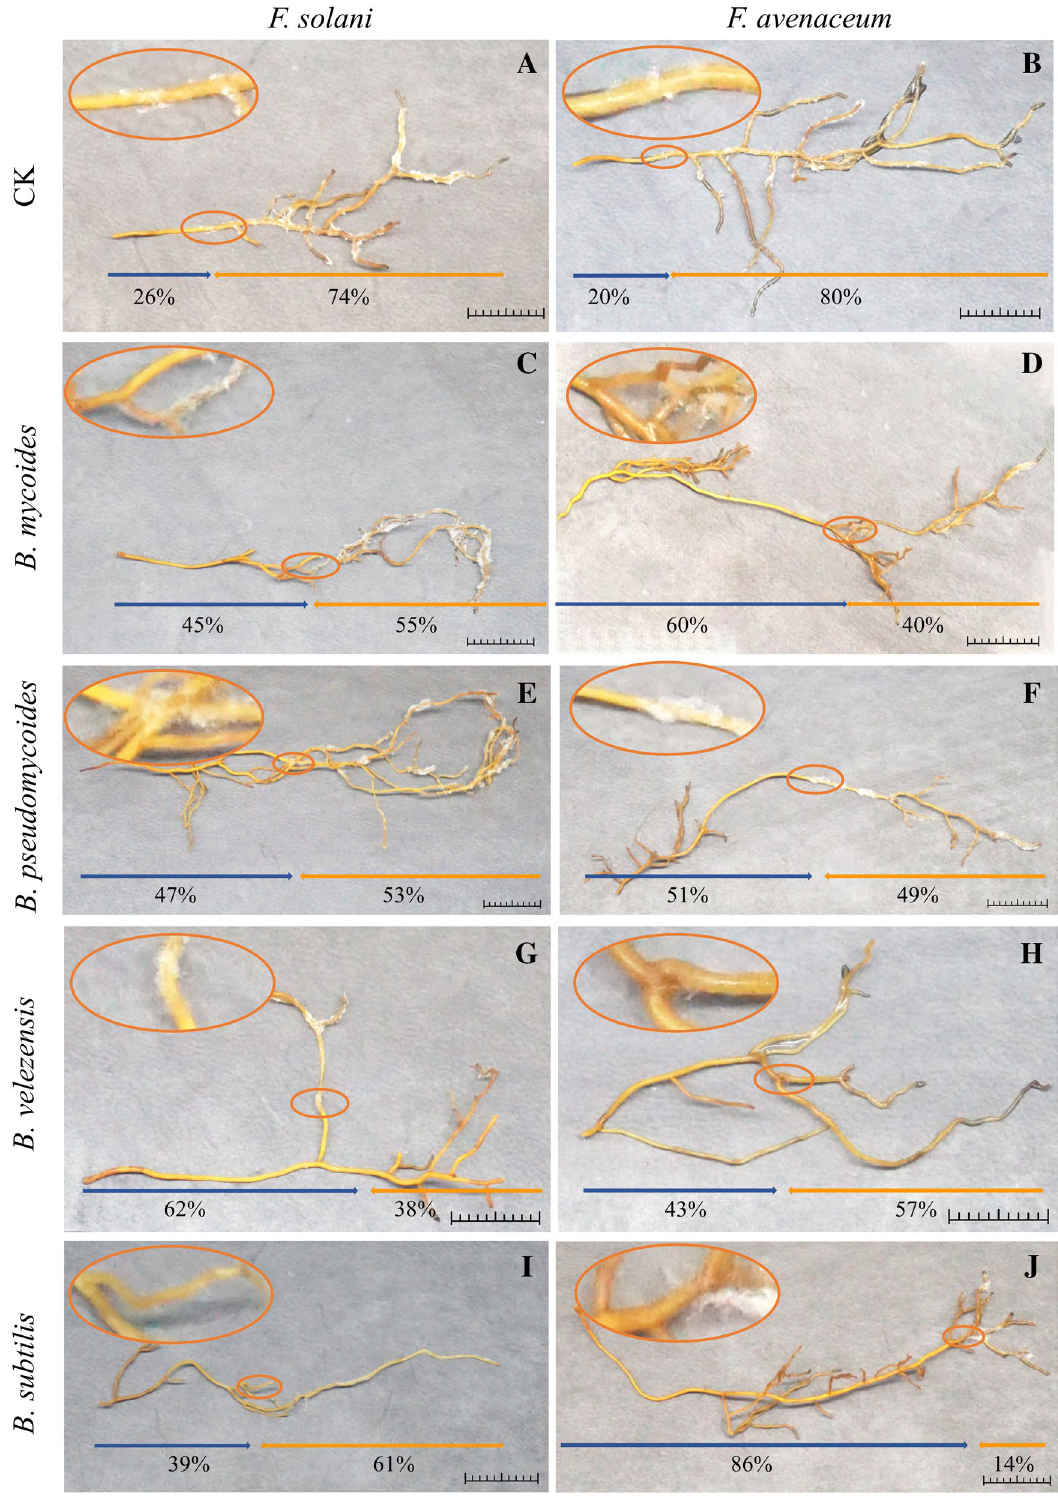
Figure 8. Bacteria with antagonistic activity against root rot pathogens of Cc in detached roots. The place within the leftmost (base side) 10 mm of fibrous roots were inoculated with 100 μL sterile water (CK, A , B ), and suspension of B. mycoides ( C , D ), B. pseudomycoides ( E , F ), B. velezensis ( G , H ), and B. subtilis ( I , J ), The place within the rightmost (apical side) 10 mm of fibrous roots were inoculated with 100 μL spore suspension of F. solani ( A , C , E , G , I ) and F. avenaceum ( B , D , F , H , J ). The length of the orange arrow represents the proportion of root colonized by fungus. The length of the blue arrow represents the proportion of root colonized without fungus. Scale bar 1